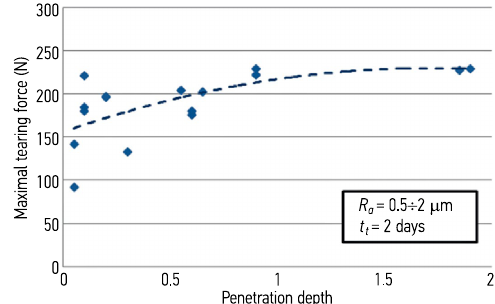
Fig. 7. Influence of penetration depth on maximal